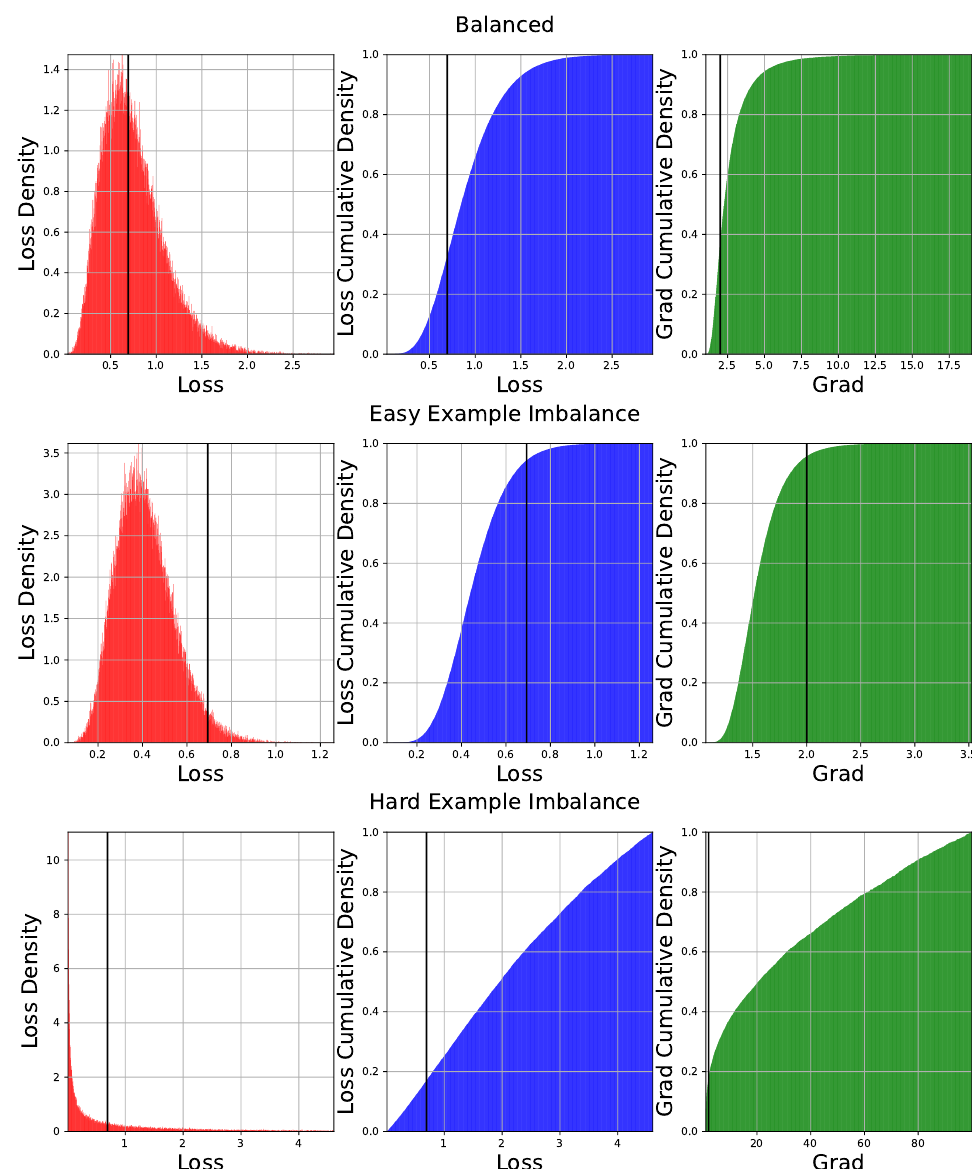
Figure 1. The point-wise loss histogram, loss cumulative histogram, and gradient cumulative histogram in three conditions: balance, easy example imbalance and hard example imbalance. The black line is the “critical” point of the prediction above which the prediction is wrong and or vice